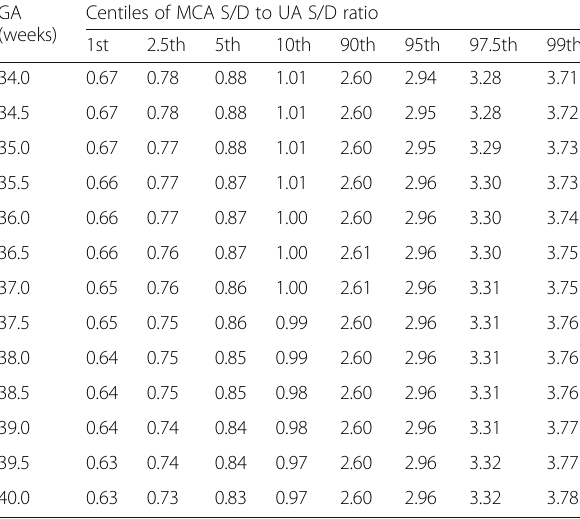
Table 3 Gestational age-defined reference ranges for MCA S/D to UA S/D ratio